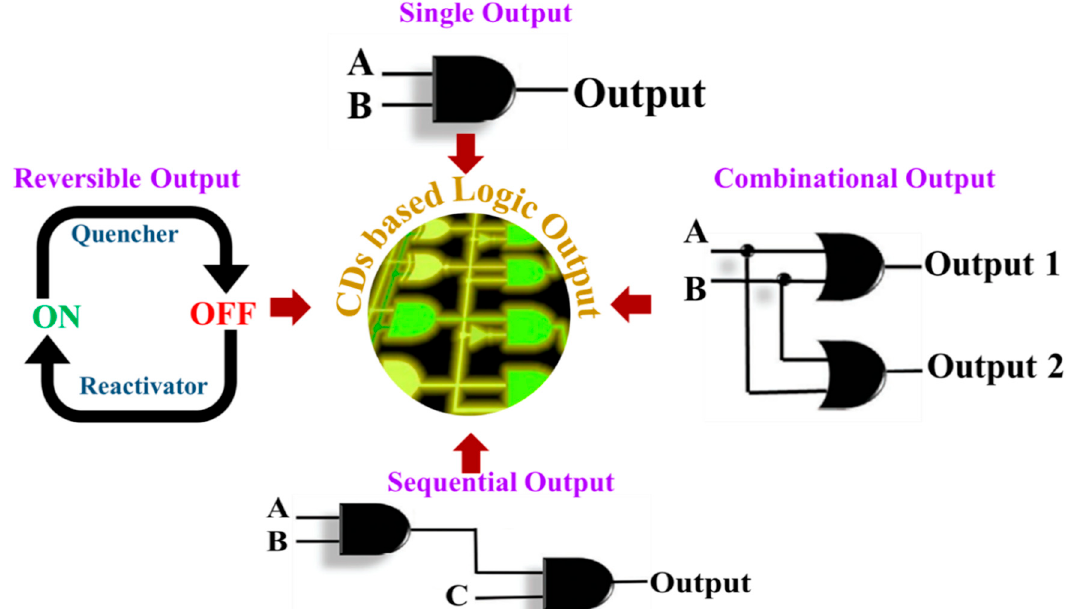
Figure 2. Different categories of carbon dots (CDs)-based logic gates according to their output. I. Single output, where only one output is generated. II. Combinational outputs are the integration of simple logic operations to obtain the complex combinational output. III. Sequential output, which responds to multiple inputs but with different stages of activation that should happen in a predestined order. IV. Reversible systems can switch between ON and OFF states depending upon the input added to the system.